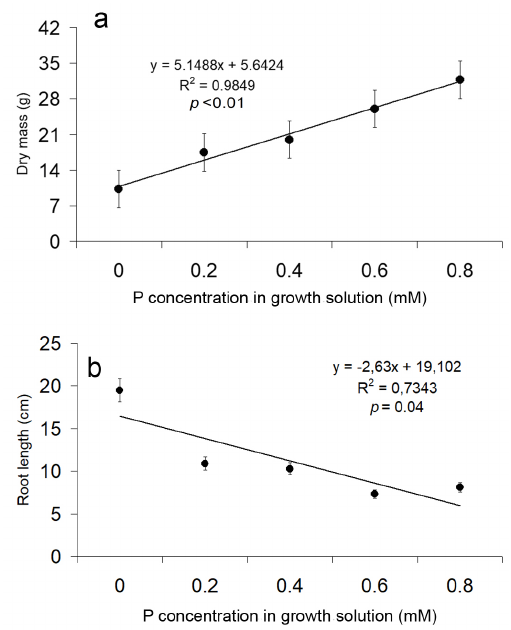
Figure 1. Dry mass and root length of T. domingensis plants grown under different phosphorus levels in the nutrient solution. Bars= standard